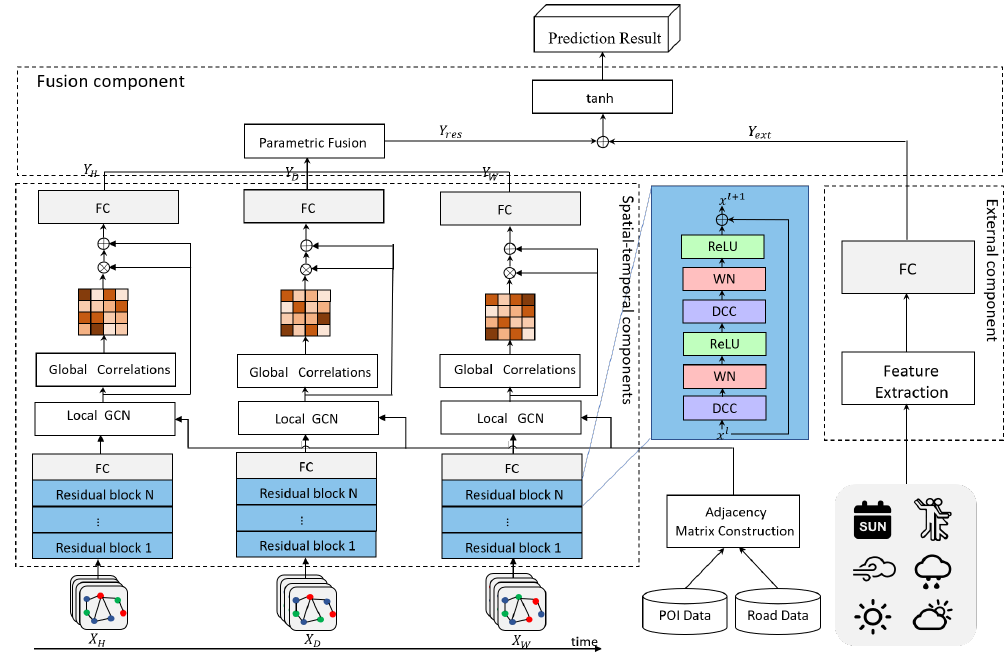
Figure 4. The architecture of